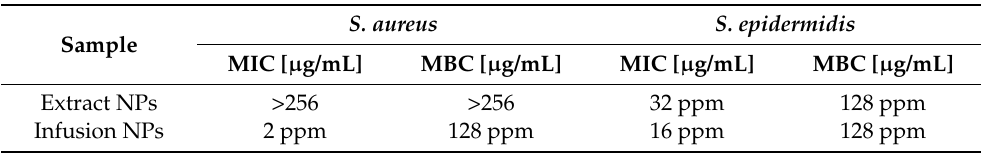
Figure 8. Immunocompatibility test results of C. incanus extract ( a ), infusion ( b ), AgNPs prepared with extract ( c ), and AgNPs obtained with infusion ( d ) toward human monocytic THP1XBlueTM cells compared with the positive control (PC) and untreated cells (NC). Statistically significant differences ( p < 0.05) calculated in comparison to untreated cells (NC) are marked with *. Table 3. The antimicrobial activity expressed as minimum inhibitory concentration (MIC) and minimum bactericidal concentration (MBC),